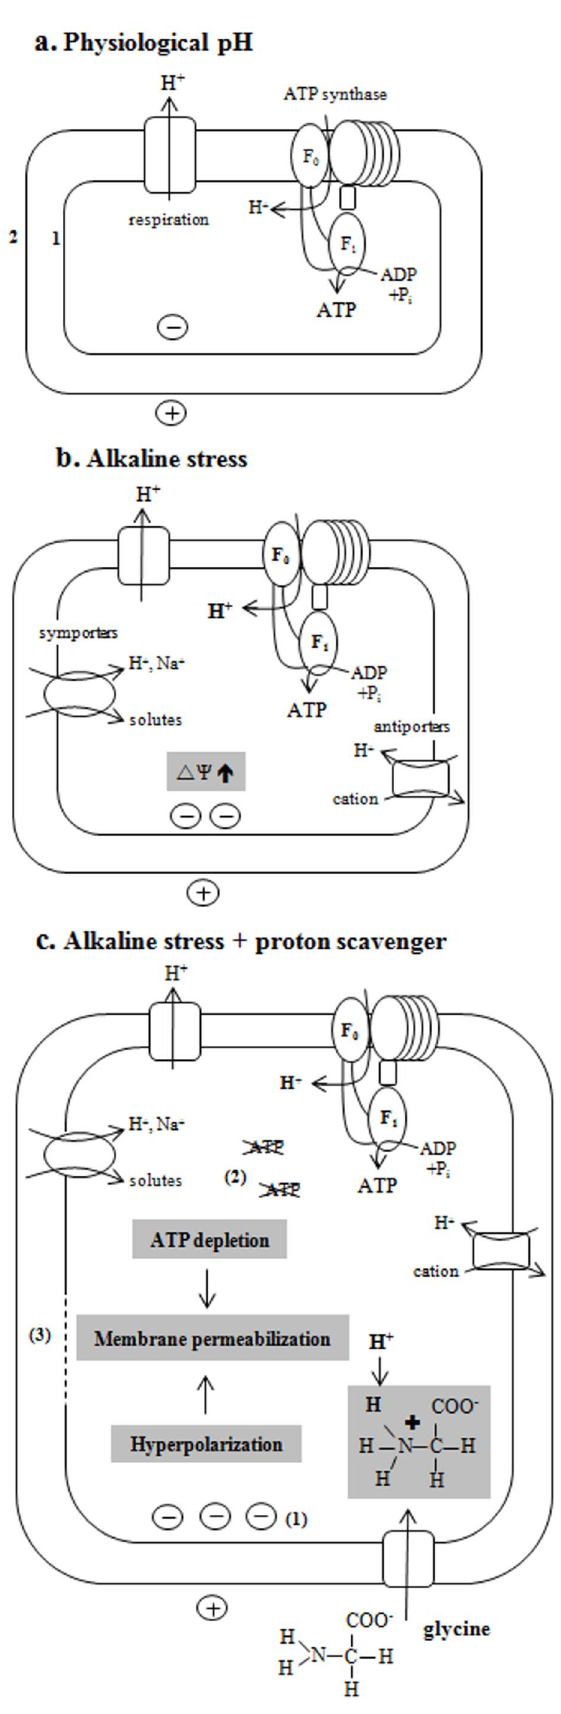
Figure 1. Maintaining E.coli pH homeostasis at physiological pH (a). During respiration, protons (H + ) are pumped extracellularly, while ATP synthesis via the F o F 1 -ATP synthase complex moves protons intracellularly. F o F 1 -ATP synthase converts the free energy of the proton motive force (PMF) into the chemical energy source ATP. Under physiological conditions, the extracellular pH is more acid than the intracellular pH. The cytoplasmic membrane is negatively charged on the inside, and positively charged on the outside. (1) represents the cytoplasmic membrane, (2) represents the outer membrane. Main- taining E.coli pH homeostasis under alkaline stress conditions (b). To prevent cytosolic alkalinisation under extracellular alkaline conditions, the cytoplasmic pH is-next to other mechanism - also regulated by the import of protons by the upregulated ATP synthase and by a multitude of cation antiport systems, pumping in protons. The membrane potential ( n Y ) is relatively increased (i.e. more negative) to compensate for the inverted proton concentration gradient ( n pH). Exposure of alkaline stressed E. coli to proton scavenging amines such as glycine (c) . When unprotonated glycine enters the neutral cytosol under extracellular alkaline conditions it becomes protonated. This causes membrane hyperpolarisation (1) by proton consumption and a higher ATP consumption in an effort to sustain pH homeostasis (2). These effects induced by proton scavenging lead to a loss of membrane integrity